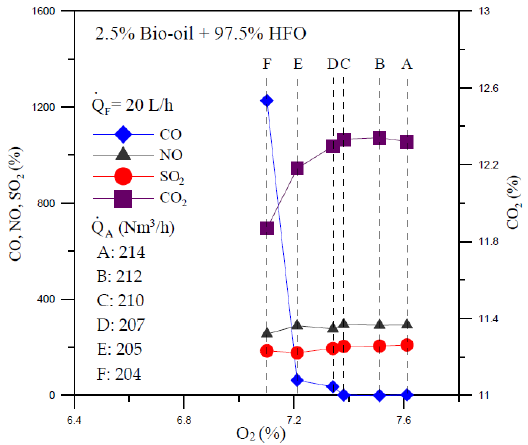
Figure 3. Combustion tuning process for burning the emulsion of 2.5% bio-oil + 97.5% heavy fuel oil (HFO).